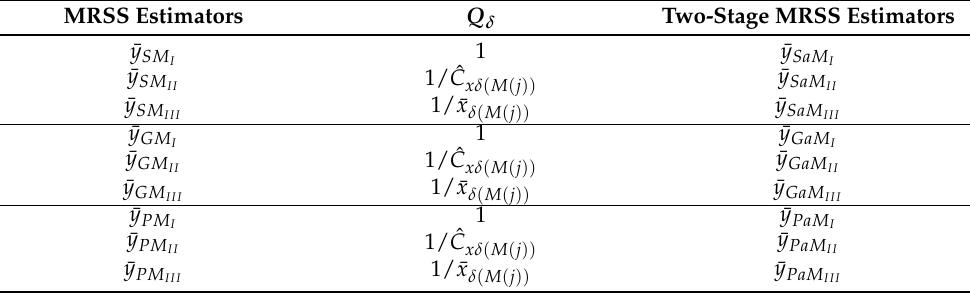
Table 3. Family members of all